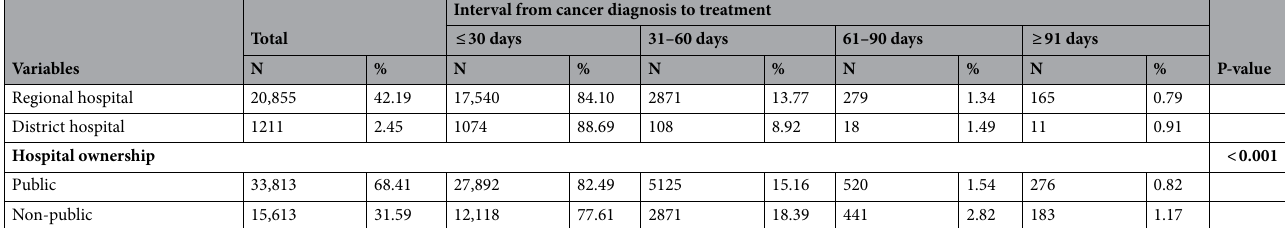
Table 1. Descriptive statistics of patients with breast cancer and different DFTIs. NTD New Taiwan Dollar (USD1 ≈ NTD30), CCI Charlson comorbidity index, ERA estrogen receptor assay, PRA progesterone receptor assay, HER2 human epidermal growth factor receptor 2, RT radiotherapy, Chemo chemotherapy, HT hormone therapy, TT targeted therapy. a Exclusion of cancer from the CCI score. Significant P values (< 0.05) are highlighted in